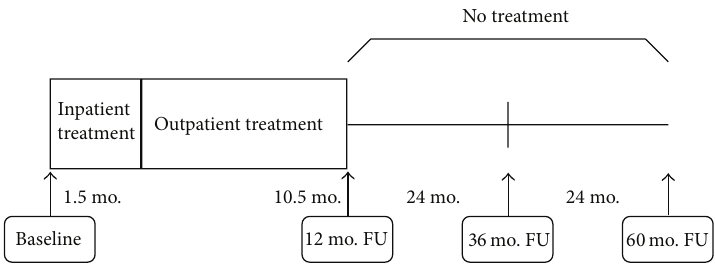
Figure 1: Study design (FU = follow-up; mo. =